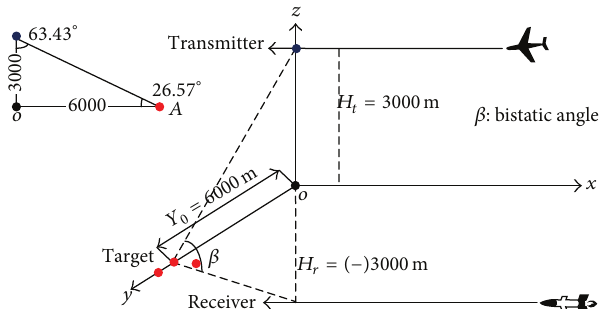
Figure 14: The geometry diagram in the simulation of bistatic case.